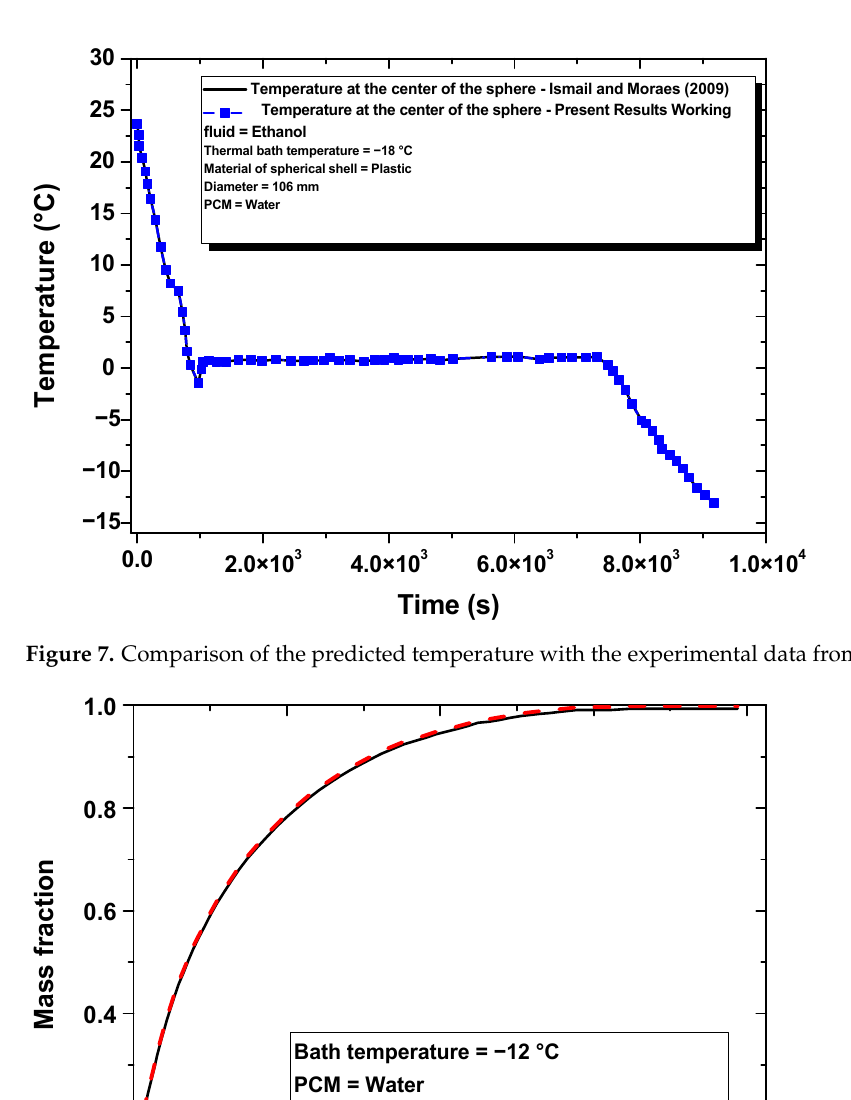
Figure 6. Numerical and experimental temperature change in the solidification process of the 106 mm diameter plastic spherical capsule.